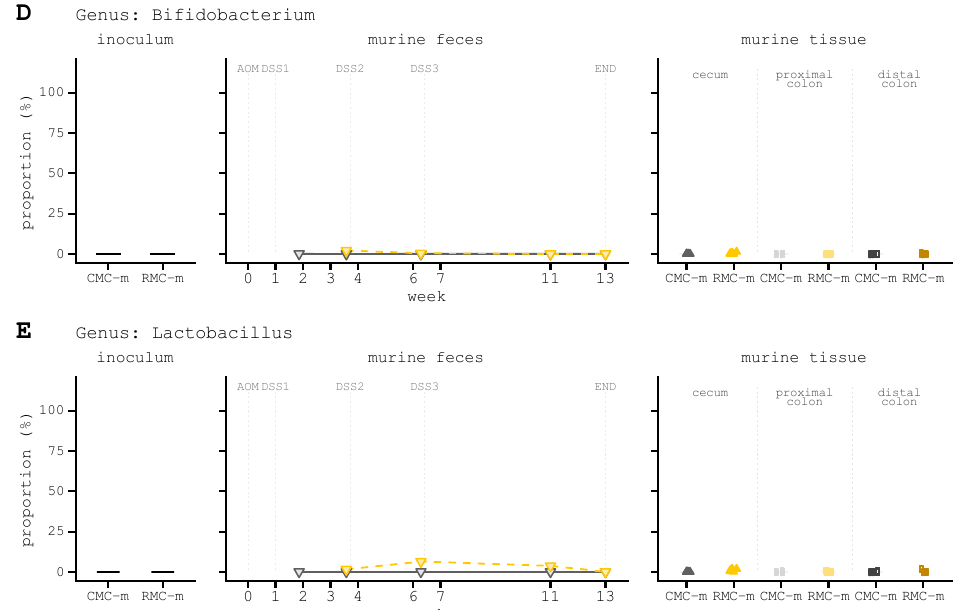
Figure 4. Taxonomic composition (proportions) of human male donor stool inoculums into murine feces, cecum, and colon. ( A ) Firmicutes proportions for stool inoculums and samples from mice colonized with consortia derived from the human male. ( B ) Bacteroidetes ( C ) Lachnospiraceae ( D ) Bifidobacterium ( E ) Lactobacillus ( A – E ) the y ‐ axis is identical across plots within a given panel and is set at 100% for all panels depicted. Taxonomy was collapsed at the phylum ( A , B ) family ( C ) or genus ‐ ( D , E ) levels to combine proportions for identical assignments prior to visualization. Taxonomy was assigned using the SILVA 132 marker gene database.